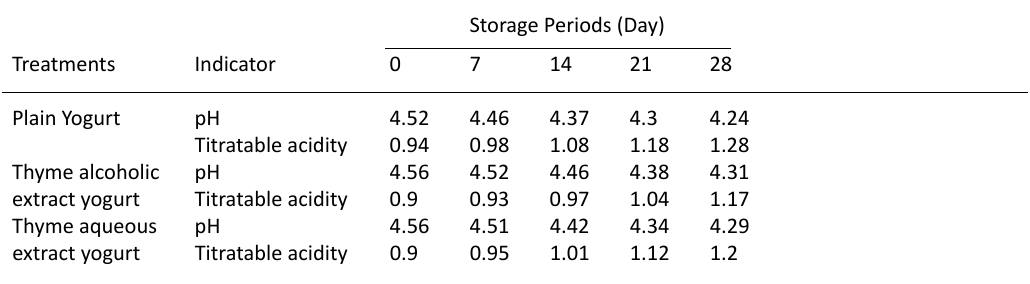
Storage Periods (Day)